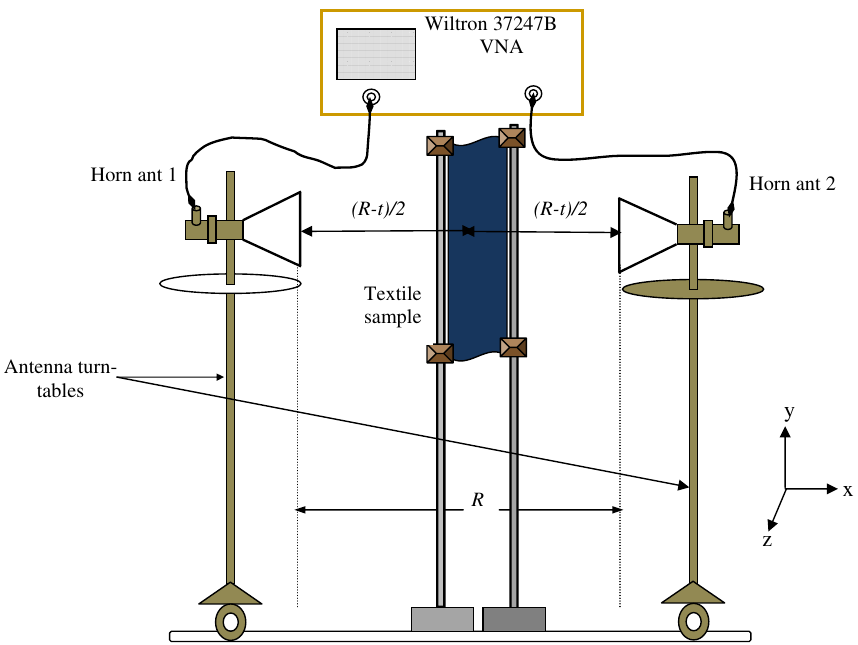
Fig. 2. Schematic diagram of a laboratory developed free-space measurement set up.